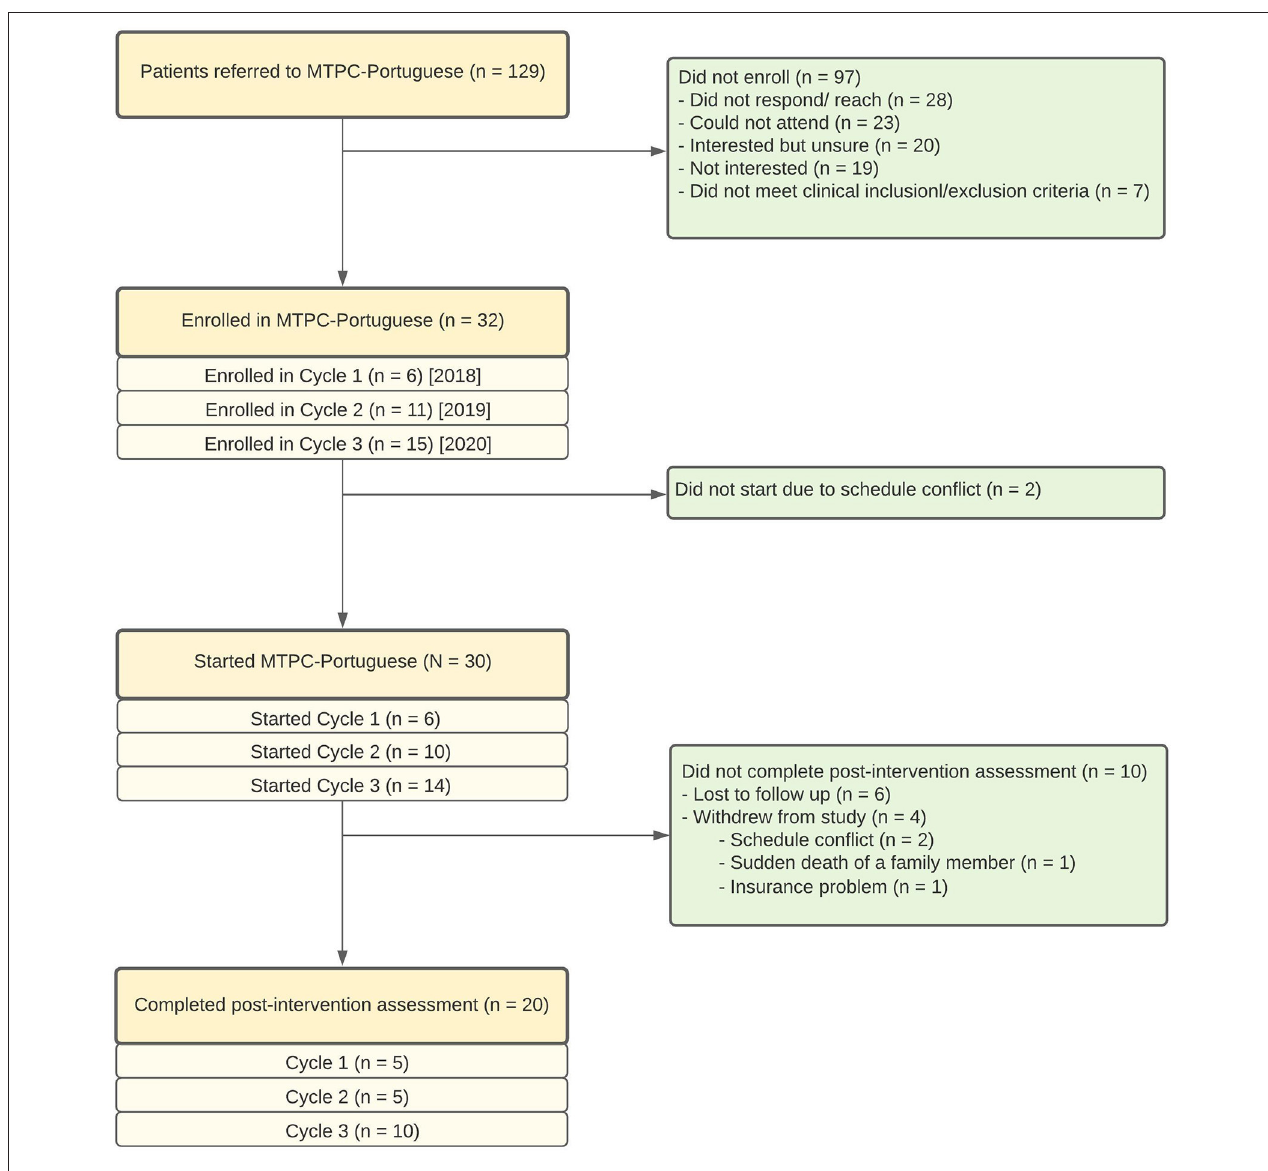
FIGURE 1 | Flow diagram of the